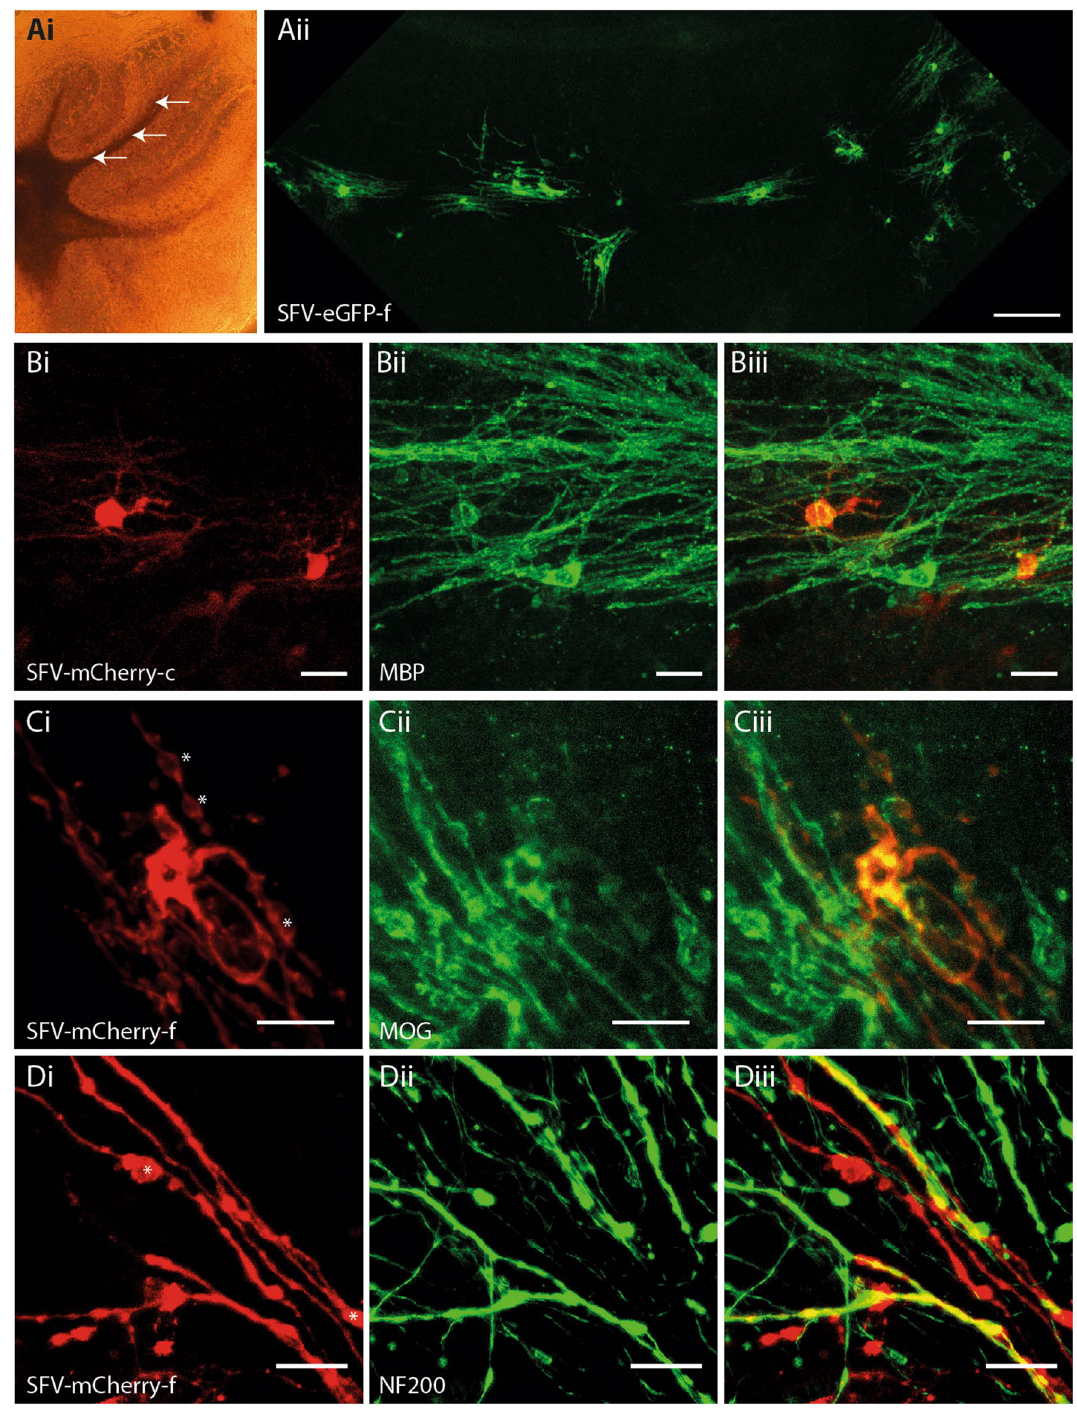
Figure 1. SFV transduces myelinating OL in cerebellar slice cultures. ( Ai ) Phase contrast image of a cerebellar slice culture illustrating white matter tracks and typical sites for SFV injections (arrows). ( Aii ) OL with a myelinating morphology are labelled throughout the entire white matter track of one folium 24 h after injection of SFV encoding eGFP-f. Magnification 10 ×, Scale bar 100 µm. ( B ) SFV labelled OL express MBP. ( Bi ) Cytoplasmic mCherry (mCherry-c) in two white matter cells with typical myelinating OL morphology. ( Bii ) MBP immunofluorescence in the field shown in ( Bi ). ( Biii ) Merged image indicating localization of anti-MBP (green) to the processes of the mCherry + (red) cells depicted in ( Bi ). Magnification 20 ×, Scale bars in ( B ) panels 20 µm. C. SFV labelled cells localize MOG. ( Ci ) mCherry-f labelled white matter glial cell with myelinating morphology. ( Cii ) MOG immunofluorescence in the field shown in ( Ci ). ( Ciii ) Combined mCherry and MOG signals indicate colocalization of anti-MOG (green) and mCherry (red) signals. Magnification 40 ×, Scale bars in ( C ) panels 20 µm. ( D ) Axonal interactions of SFV labelled OL. ( Di ) High power (40 ×) image of processes (red) extending from an OL transduced with SFV-mCherry-f. ( Dii ) Axons (green) from the field depicted in Di labelled with anti-NF200. ( Diii ) Merge image indicating localisation of NF200 on SFV labelled processes (yellow). Asterisks in Ci and Di indicate mCherry-f labelled membrane bubbles. Scale bars in ( D ) panels 20